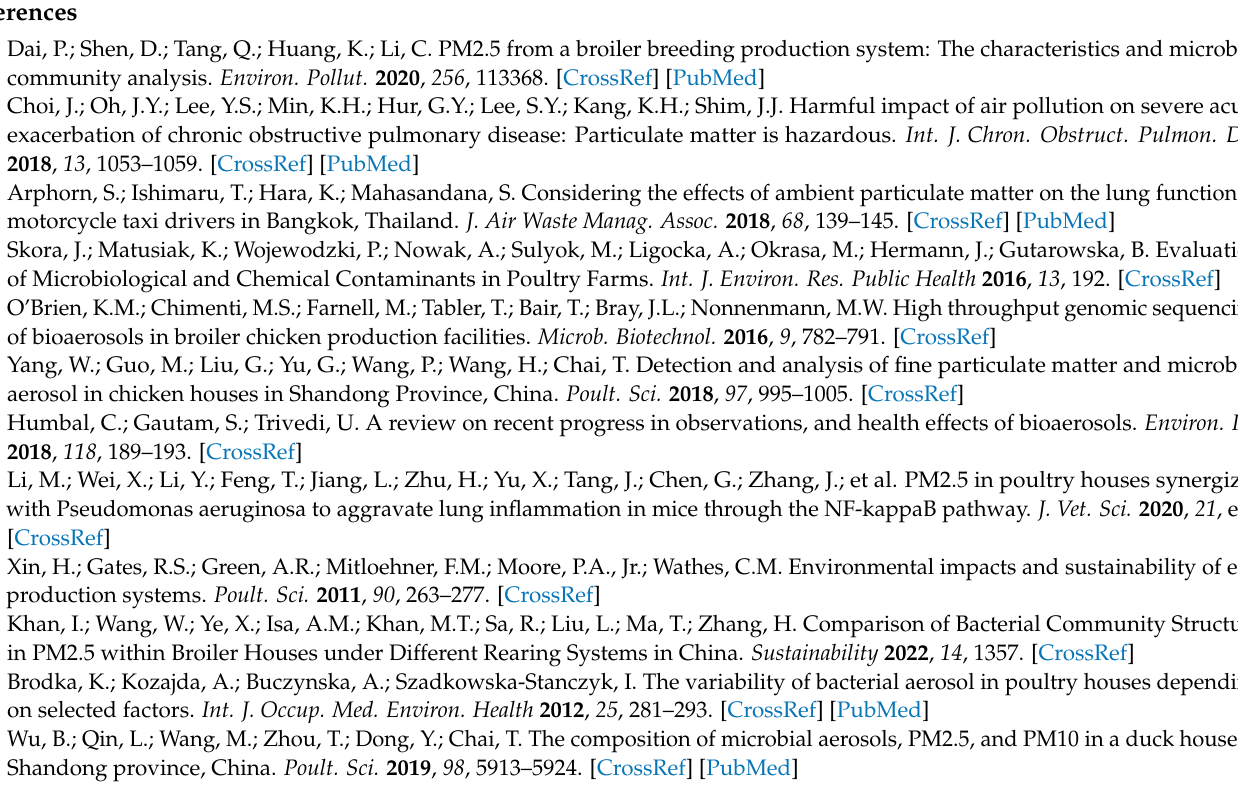
Figure S4: The relative abundance of manurial and indoor airborne bacteria at the phylum level; Table S1: Related data table of